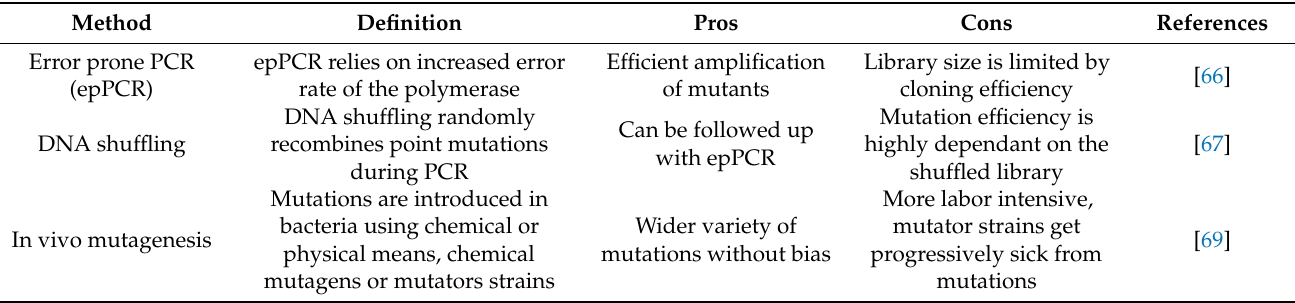
Table 2. Overview of random mutagenesis